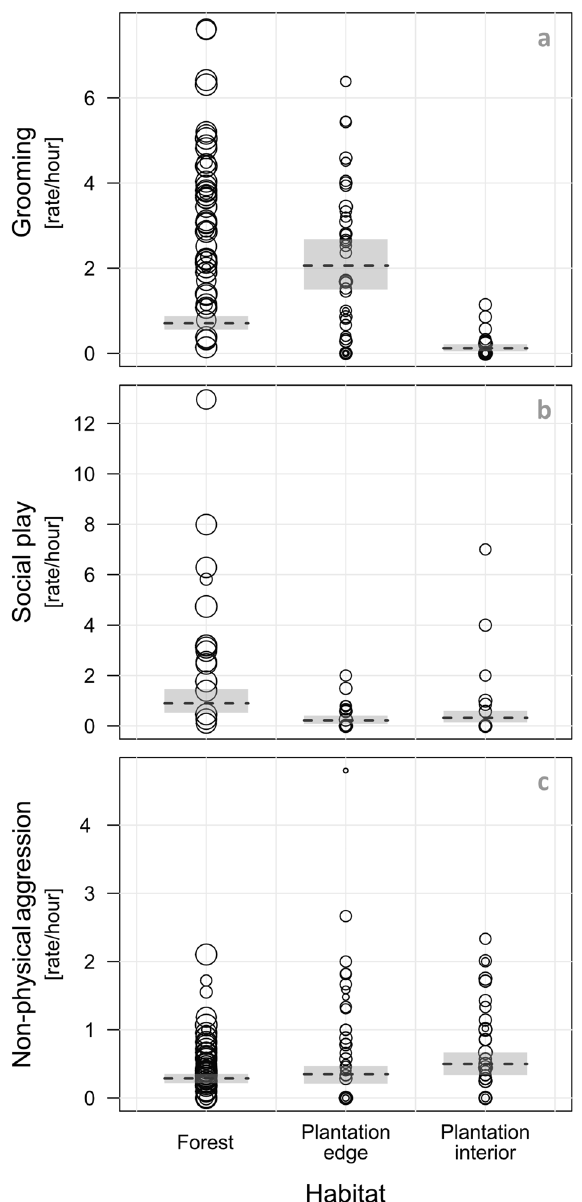
Figure 3. Effect of oil palm plantations on social interactions in Macaca nemestrina . Shown are individual rates of grooming ( a ), juvenile social play ( b ) and non-physical aggression ( c ) in the forest, at the plantation edge and in the plantation interior (additional illustration in Supplementary Fig. S1). The dashed lines show the fitted models and the shaded areas their 95% confidence intervals, conditional on continuous control predictors being on their average, and based on age-sex class, group and time of the day manually dummy coded and then centred. For visual clarity, observation values were averaged per individual, with circle areas corresponding to respective observation hours per focal animal (Total N = 1535 focal observations of 50 individuals (36 of AMY , 14 of VOL ) for grooming and non-physical aggression, and 510 focal observations of 16 individuals (14 of AMY , 2 of VOL ) for social